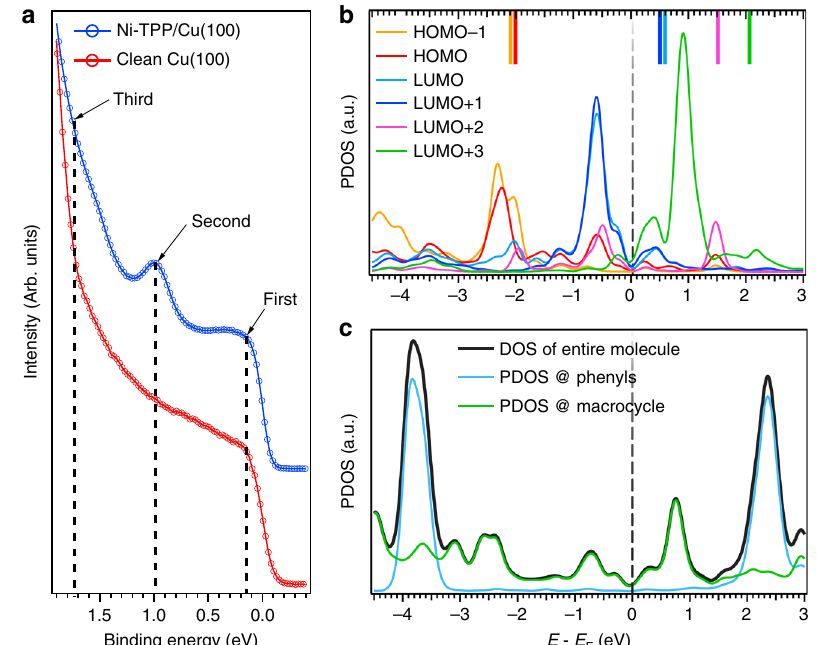
Fig. 4 Electronic structure of Ni-TPP/Cu(100). a Photoemission spectra of clean Cu(100) and Ni-TPP/Cu(100) acquired at 26 eV photon energy. b PDOS onto molecular orbitals for the Ni-TPP/Cu(100) system. The energy position of the corresponding gas-phase molecular orbitals, aligned with respect to the vacuum level, is indicated with colored bars on the top axis . c DOS of the entire molecule ( black curve ), PDOS onto the phenyl group ( light blue curve ) and on the macrocycle ( green curve )